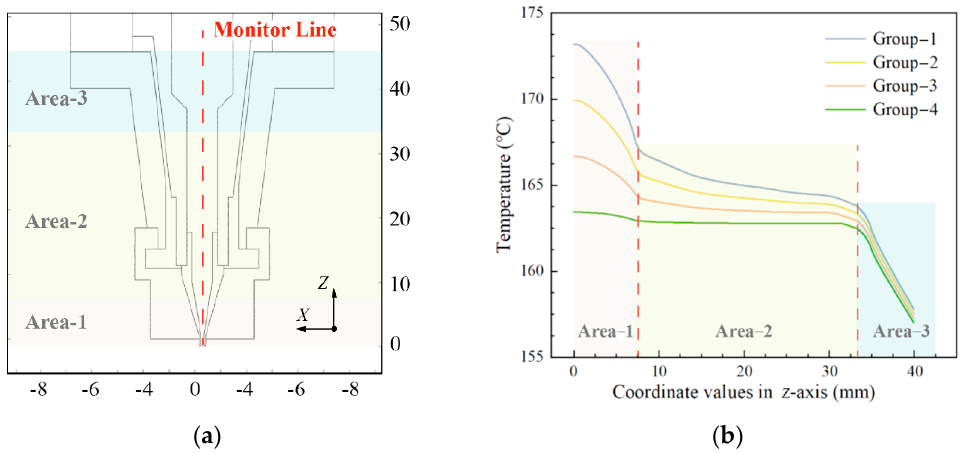
Figure 6. Quantitative comparison of temperature distribution in the cartridge: ( a ) schematic diagram around the bottom of the print head; ( b ) temperature curves of the monitor line.